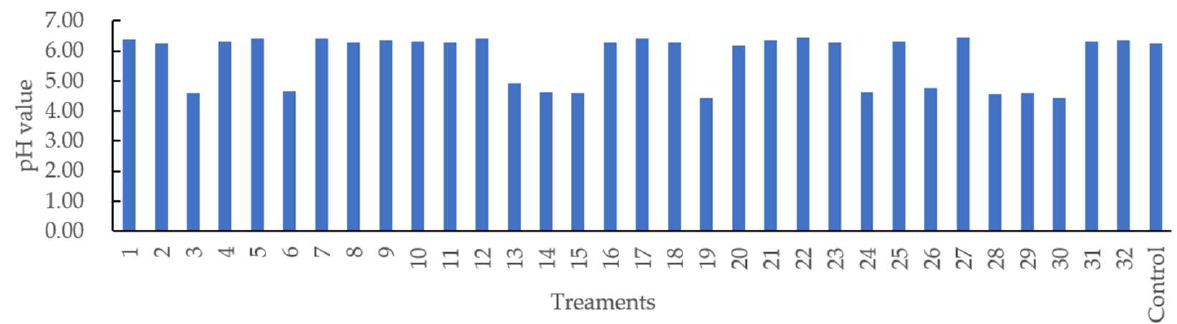
Figure 3. pH value of the sausages stuffed in modified casings with different treatments. Table 2. Regression coefficients and analysis of variance of the regression models for pH. Analysis of